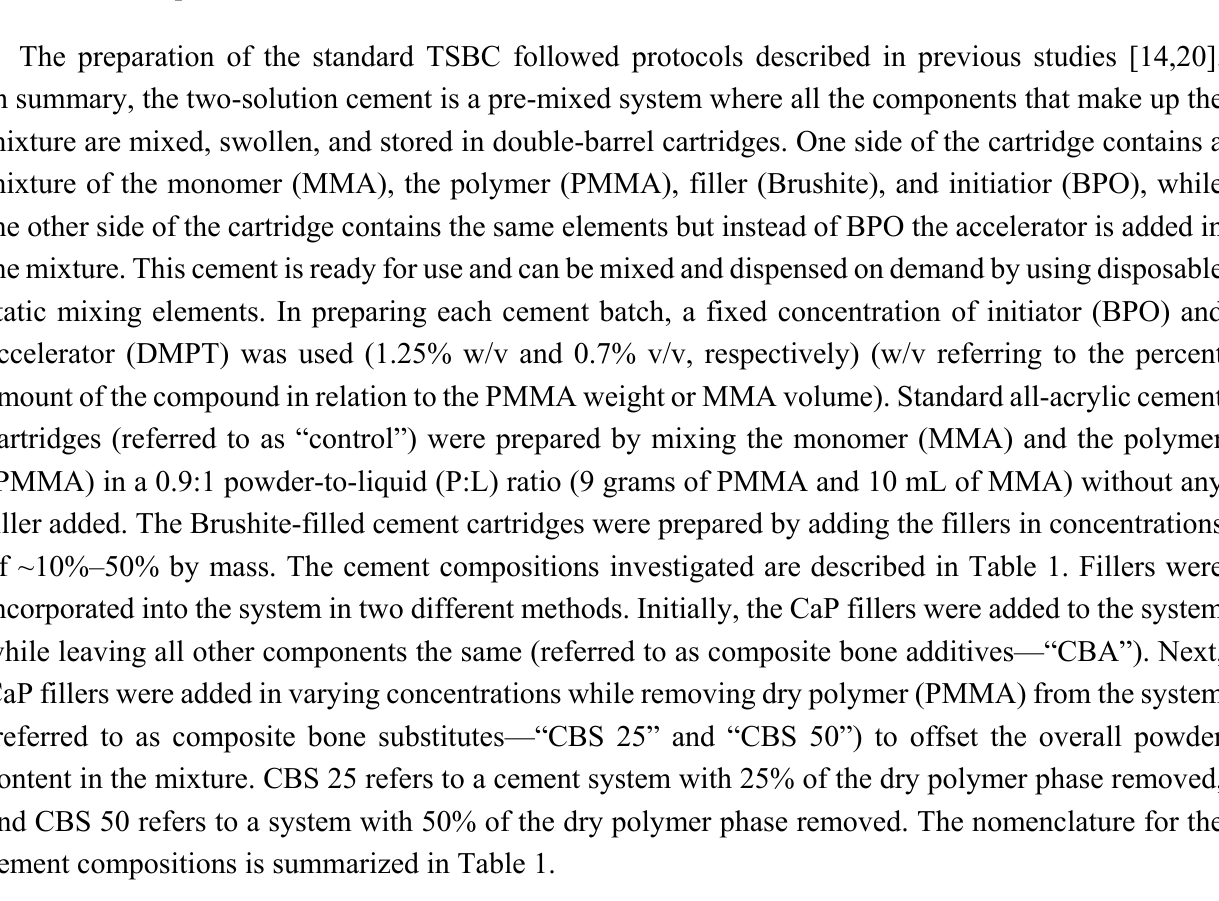
Table 1. Description of cement formulations prepared and % mass Brushite filled into each composition